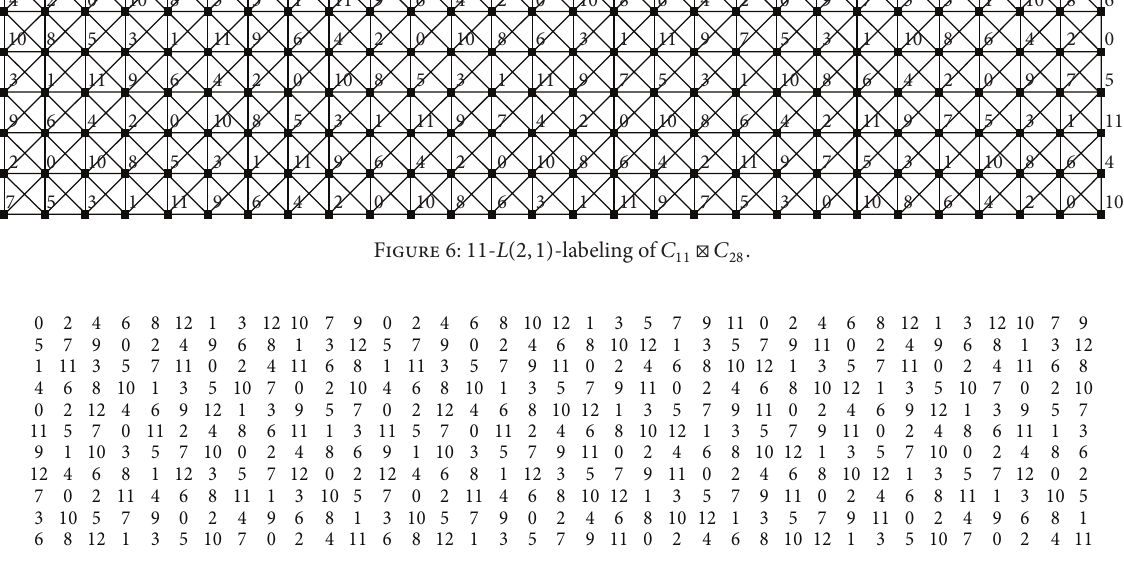
Figure 7: 12 - 𝐿(2,1) -labeling of 𝐶 11 ⊠ 𝐶 37